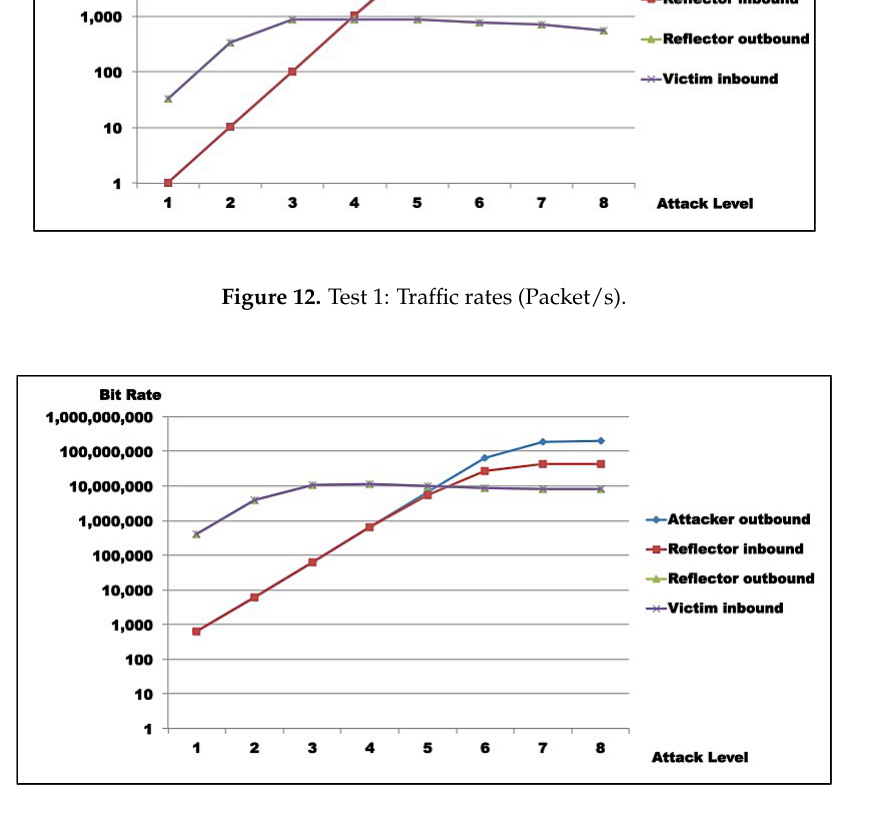
Figure 13. Test 2: Traffic rates by attack level